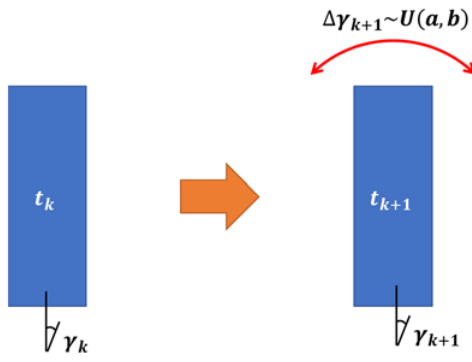
Figure 6. Simple shell case rotation model.